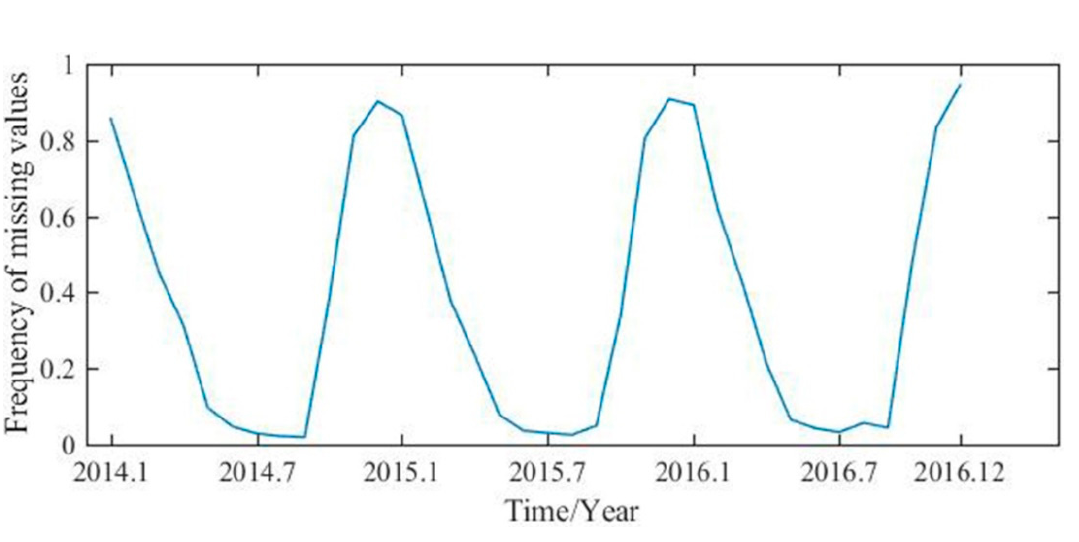
Figure A1. Frequency of missing values for evergreen needle forest in GEOV3 FVC product during 2014 to 2016.